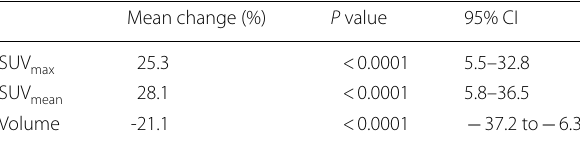
Table 2 Quantitative analysis